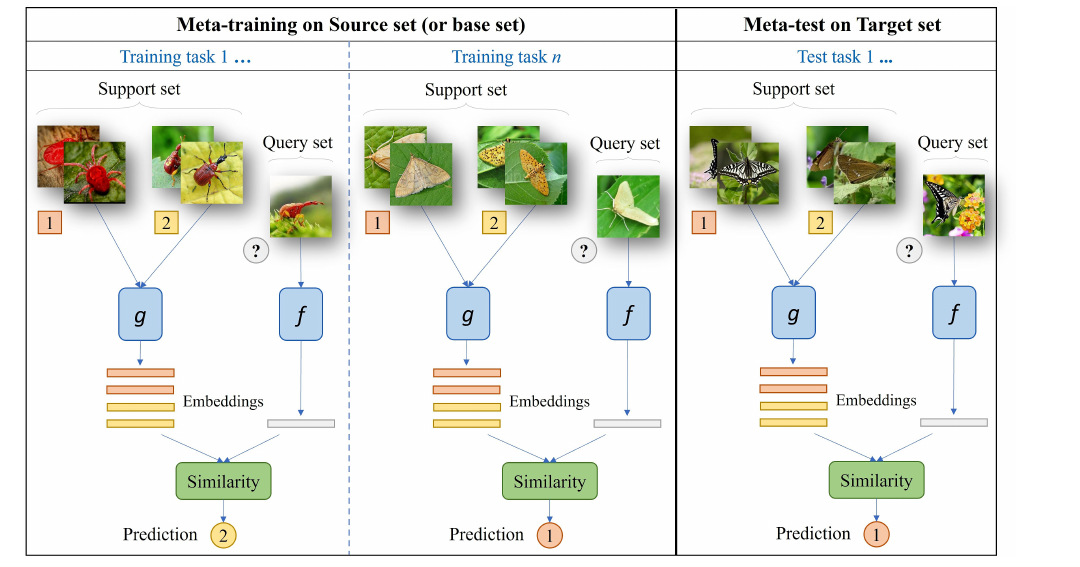
Figure 1. Meta-metric few-shot learning example representation. Illustrated settings of tasks are 2-way, 2-shot, and one query image. In some approaches, the embedding functions f and g may be the same. Query images are labeled according to a similarity score with support